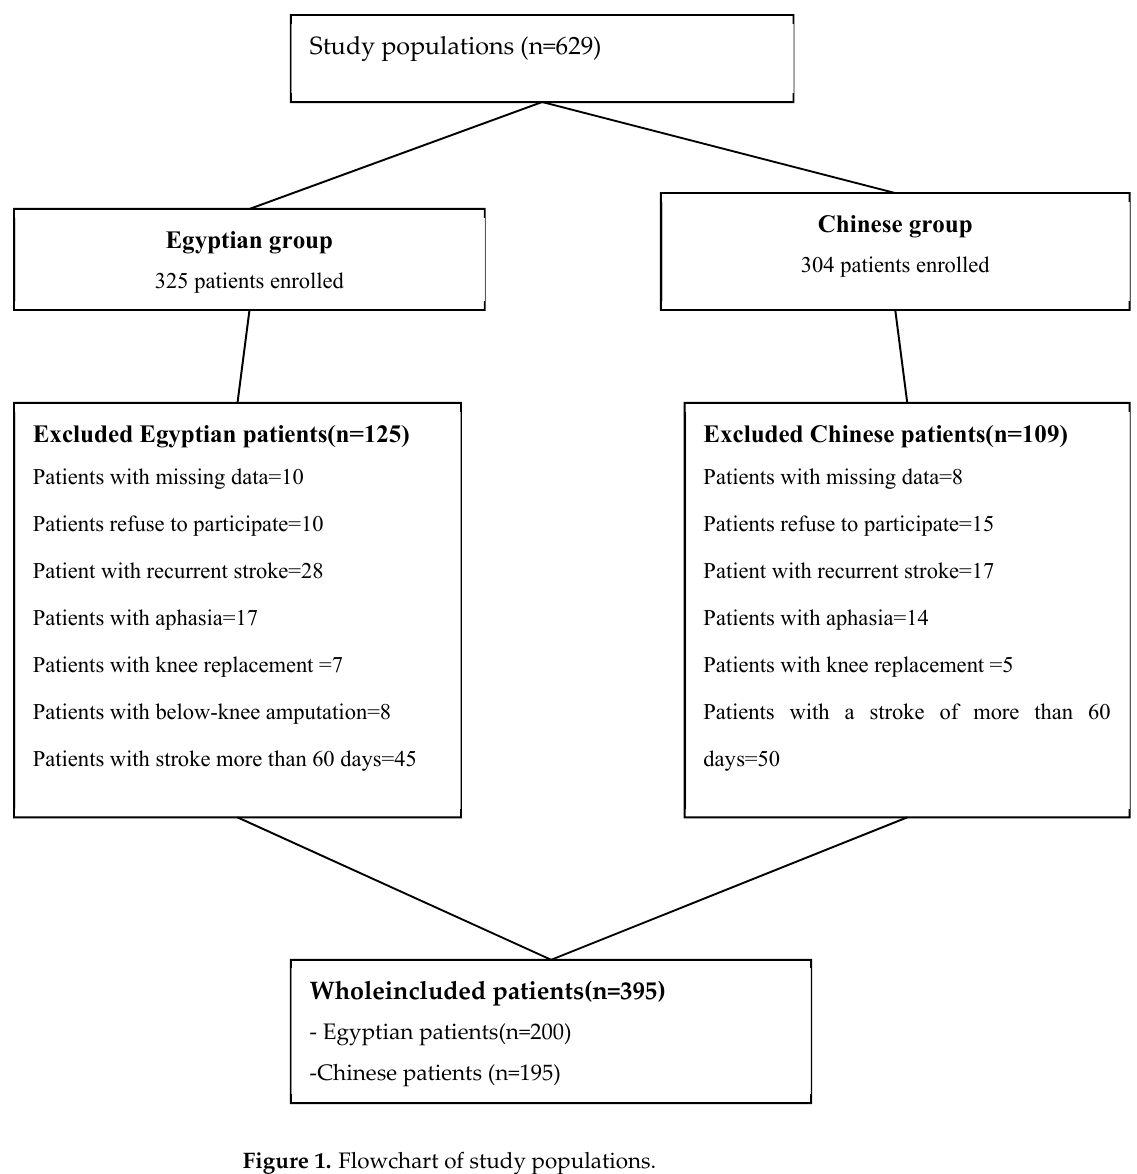
Figure 1. Flowchart of study populations .